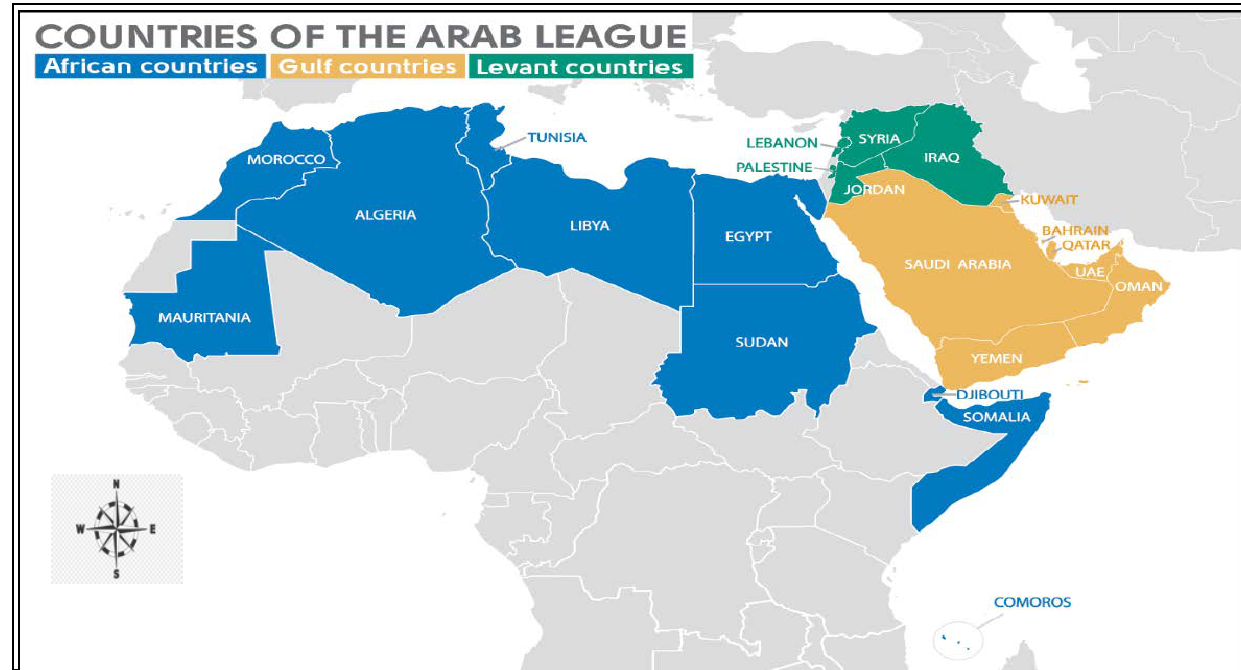
Figure 1. Map of the Arab world countries [34].